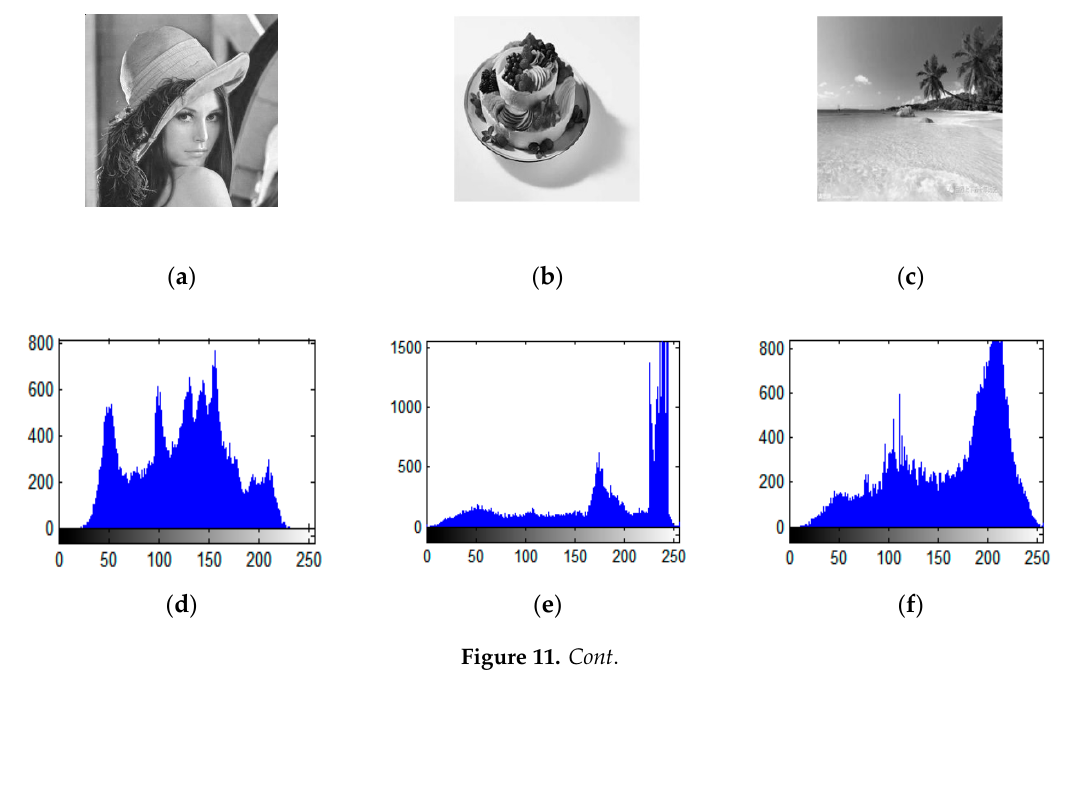
Figure 10. The key sensitivity test: ( a ) The decrypted Lena image, using the correct initial key with initial condition x 1 = 0.12; ( b ) The decrypted Lena image, using the wrong initial key with initial 1 = 0.12 + 10 − 15 . condition x (cid:48) 1